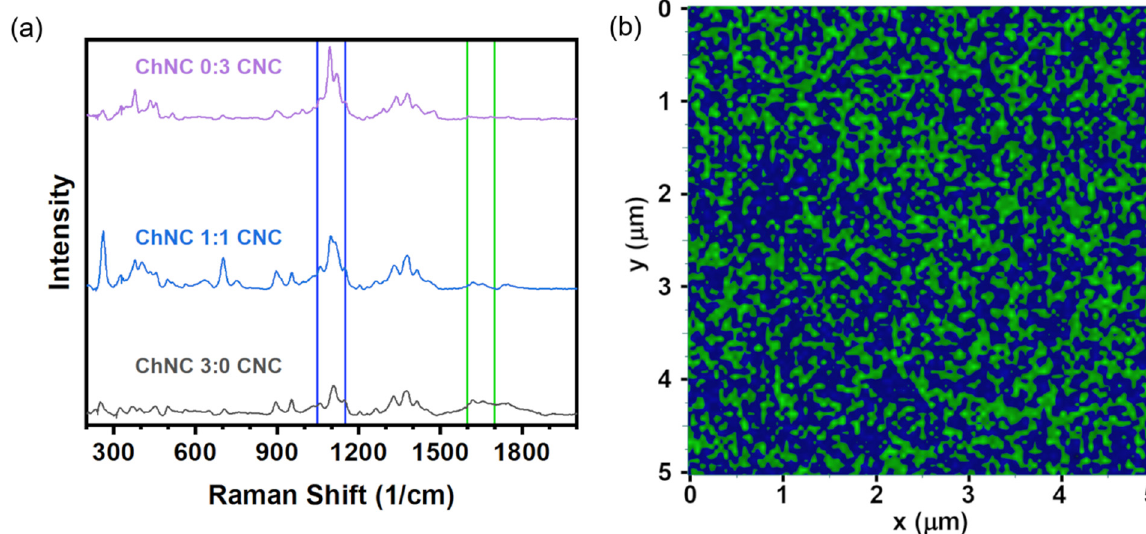
Figure 3. ( a ) Raman spectra of pure CNC, 1:1 ChNC:CNC, and pure ChNC films showing the bands used for Raman mapping. ( b ) Raman signal map of a 1:1 ChNC/CNC thin film, providing an approximate distribution of ChNC and CNC on the film. The colors represent vibrations within 1050 – 1150 cm − 1 (blue) and 1600 – 1700 cm − 1 (green).